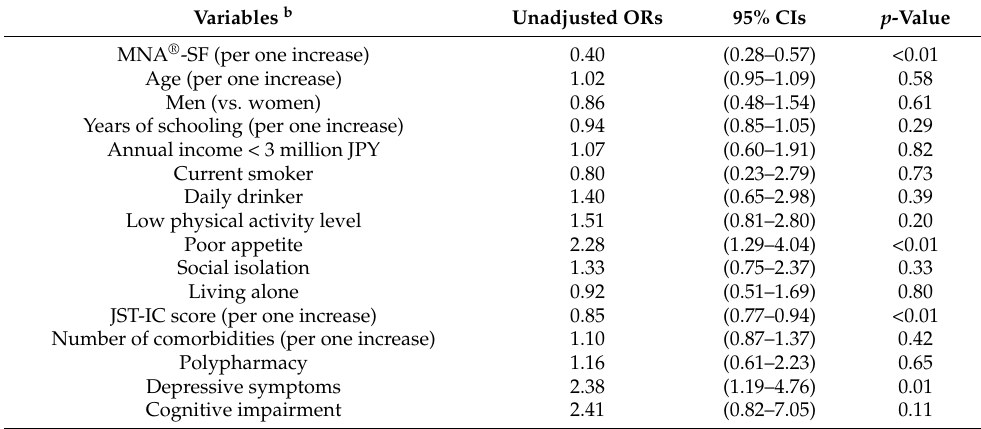
Table 3. Unadjusted ORs with 95% CIs for malnutrition in relation to study participants’ characteristics a